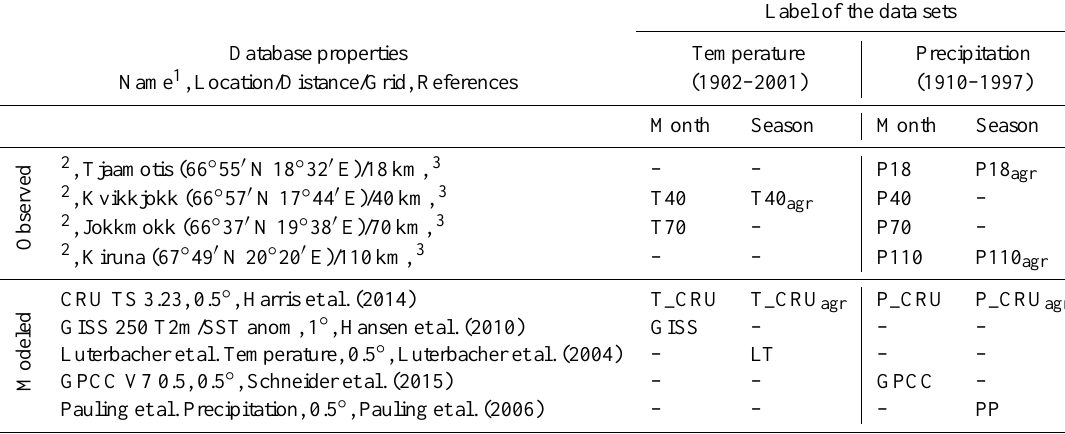
Label of the data